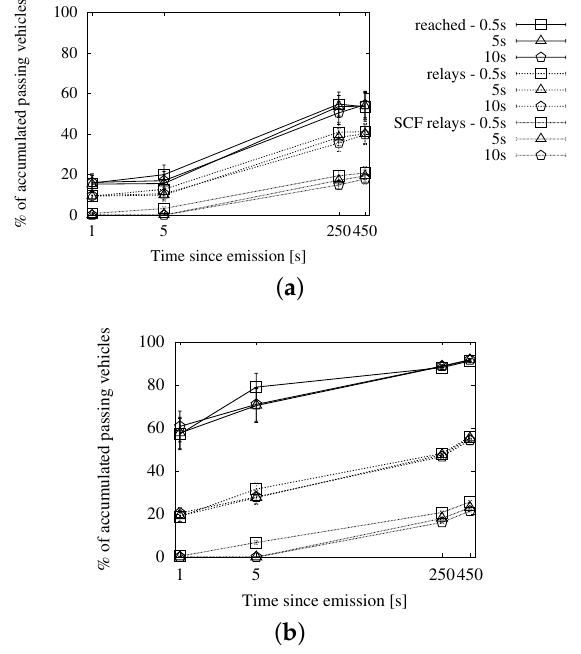
Figure 10. Involved vehicles with the fixed interval approach for store-carry-forward in the New York scenario: ( a ) roadway scheme, 25 vehicles/km 2 ; ( b ) roadway scheme, 100 vehicles/km 2